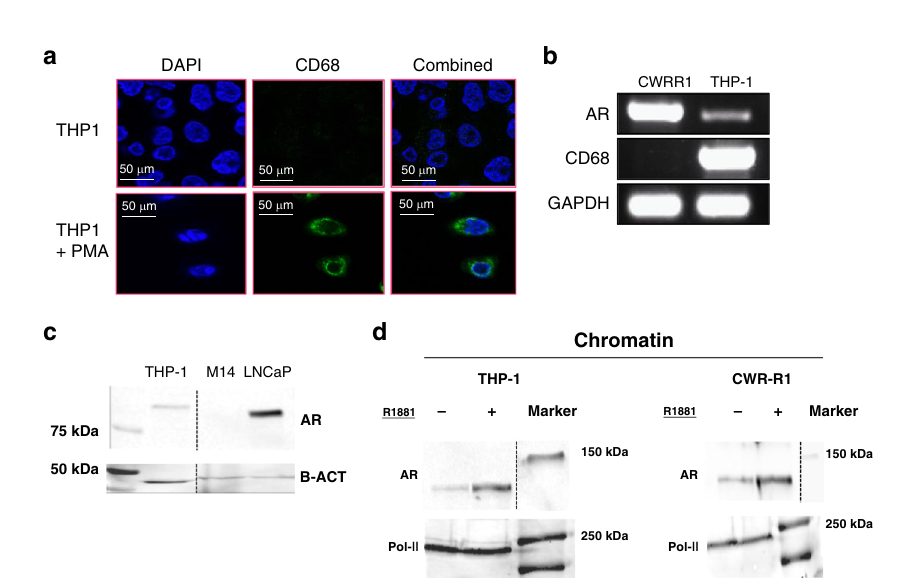
Fig. 2 AR expression and nuclear translocation in THP-1 cells. a Expression of the macrophage marker CD68 (green) in THP-1 cells at steady state (no treatment) and following 2 days of PMA stimulation. Nuclei were stained with DAPI (dark blue). Scale bar = 50 µ m. Representative of three images per condition. b RT-PCR showing AR expression at the RNA level in human cancer cell lines of prostate epithelial (CWR-R1) and monocytic (THP-1 PMA;IFNG;LPS ) origin. GAPDH was used as a house-keeping control gene. This experiment was performed two times. c Western blot showing AR expression at the protein level in human cell lines originated from prostate cancer (LNCaP), melanoma (M14) and monocytic leukaemia (THP-1 PMA;IFNG;LPS ). β -Actin was used as a loading control. This experiment was performed two times. Source data are provided as a source data fi le. d Western blot showing AR expression at the protein level in the subcellular chromatin fraction of THP-1 PMA;IFNG;LPS cells and CWR-R1 human PCa cells upon R1881 stimulation. Pol-II was used as a loading control of the chromatin fraction. This experiment was performed two times. Source data are provided as a source data fi